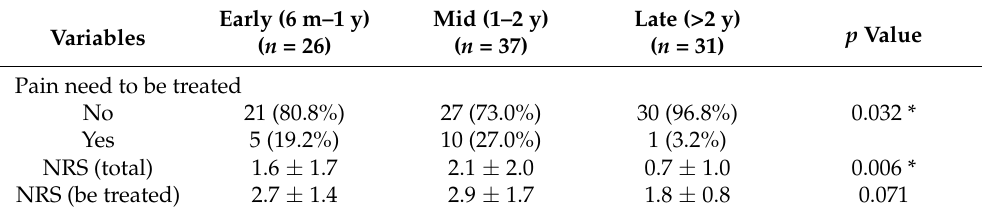
Table 6. The number of patients that need to be treated or not and its mean NRS values compared with the total mean NRS values at each time interval following anterolateral thigh flap